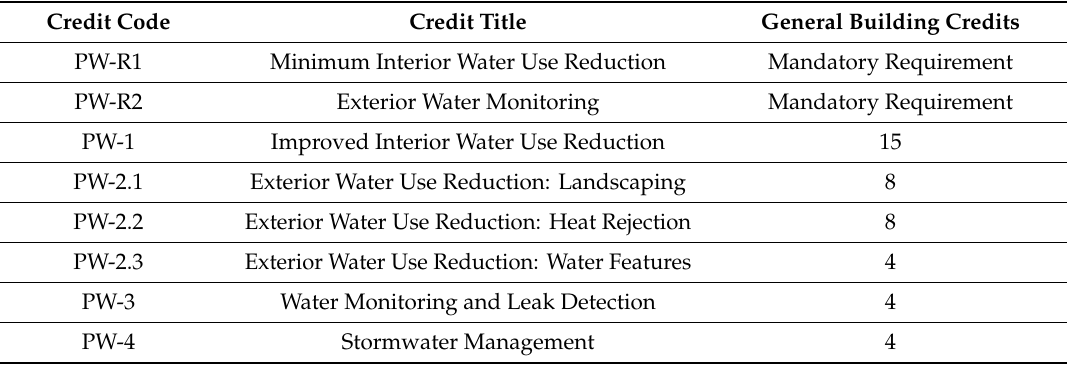
Table 3. Di ff erent credit categories under the “Precious Water” (PW) category of the Pearl Rating System. Credit